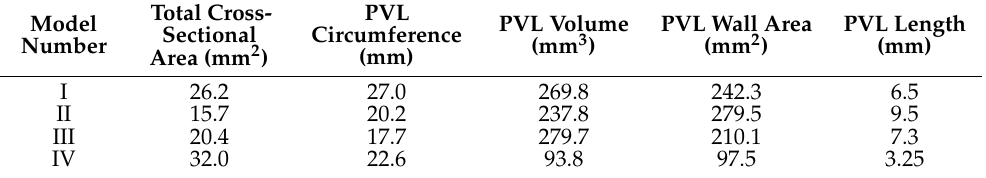
Table 2. Characteristics of PVL